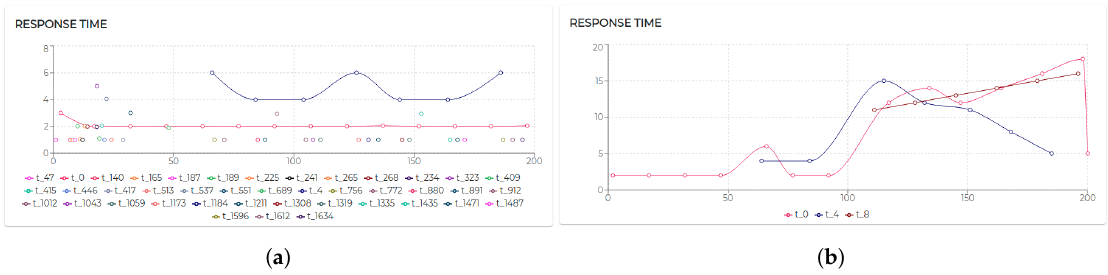
Figure 20. Comparison among the response time over 200 s of agent 4 in S3rt ( a ) and S3gp ( b ); y-axes: response time (seconds); x-axes: time